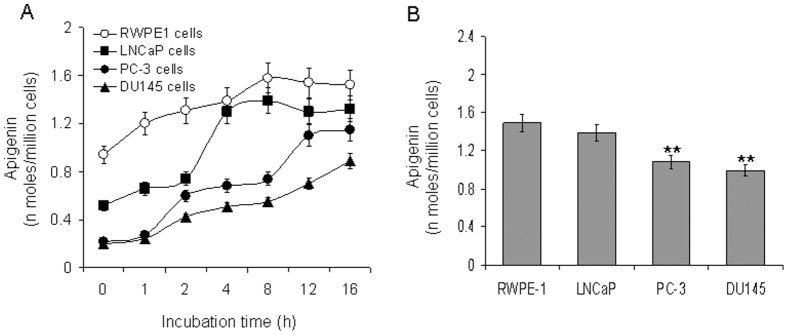
Uptake of apigenin by various human prostate cell lines.(A) Time course apigenin uptake by transformed human prostate epithelial RWPE-1 cells and prostate cancer LNCaP, PC-3 and DU145 cells incubated with 20 µM apigenin for up to 16 h. Cellular uptake of apigenin (apigenin/million cells) was determined using UV-HPLC. (B) Bar graph of apignin uptake by various cell lines at 16 h. Bars±SD of experiments performed three times. **P<0.001. Details are described in materials and methods section.